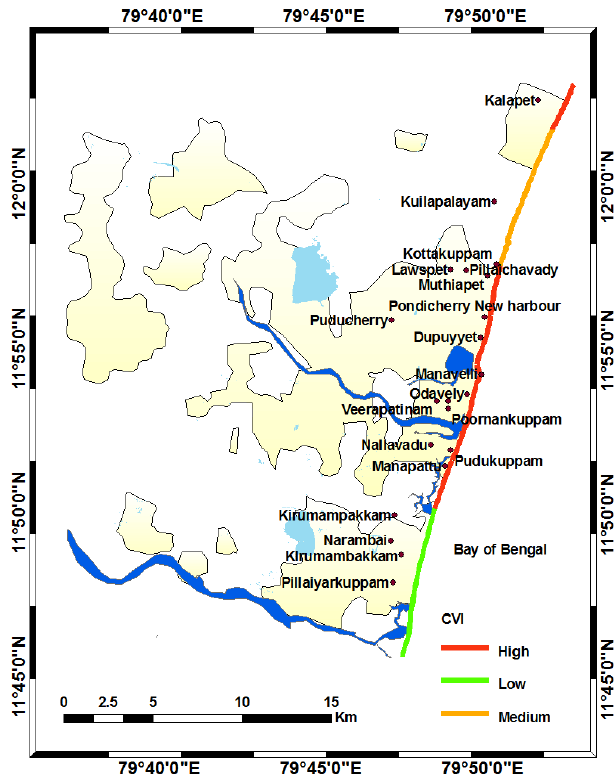
Fig. 13. Coastal vulnerability index map. Table 10. Computation of consistency ratio